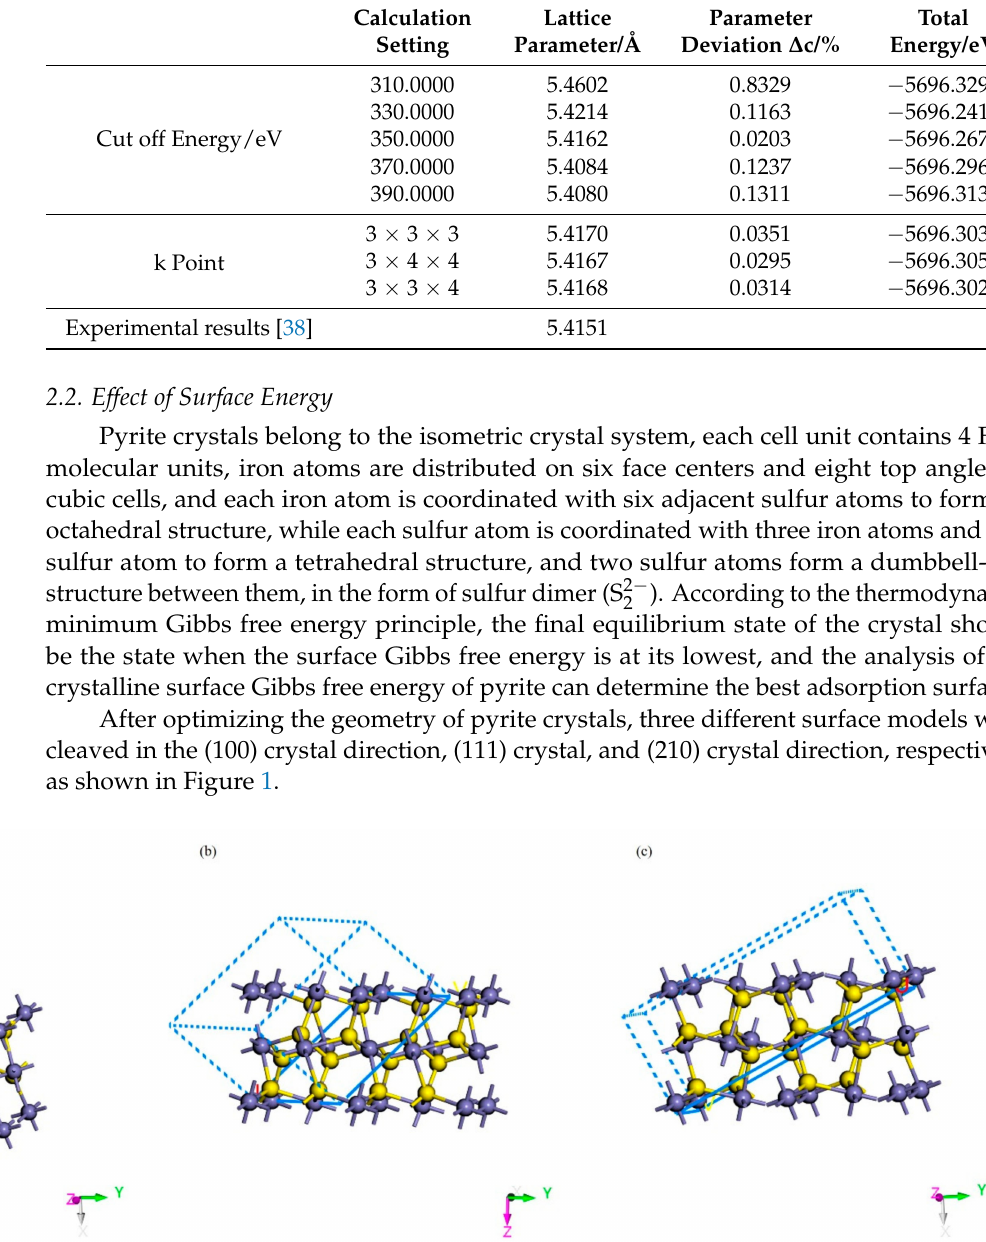
Table 2. Results of cut off energy convergence and k point tests of cubic pyrite.